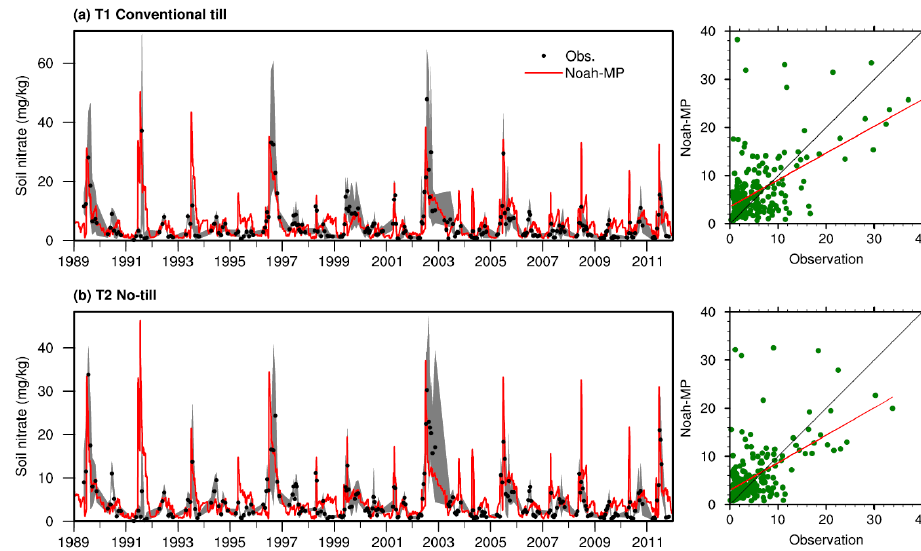
Figure 3. Observed and model-simulated soil nitrate concentration from 1989 to 2011 for (a) treatment 1 – cropland with conventional tillage – and (b) treatment 2: cropland without tillage. The grey shaded area shows the observational ranges from up to six replicates for each treatment. Table 3. Annual averages of Noah-MP-simulated major nitrogen fluxes and NPP. The NPP within the parentheses is from observation. Treatment NPP Uptake Humus Residue Denitrification Leaching (gCm − 2 ) mineralization decomposition (gNm − 2 ) Active Fixation